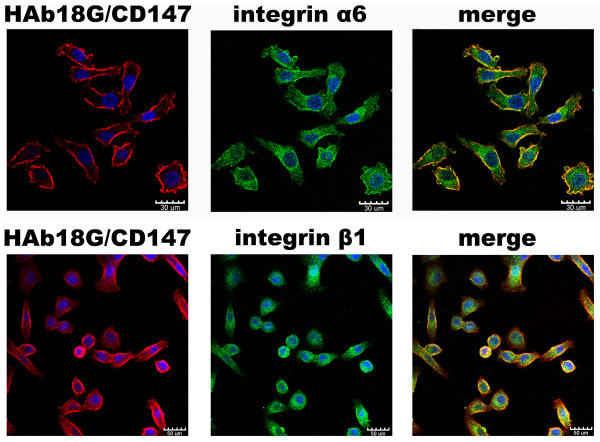
Expression and co-localization of HAb18G/CD147 with integrin α6 and β1 subunits in FHCC98 cells. FHCC98 cells were double-stained for HAb18G/CD147 (red) and integrin α6 or β1 (green).